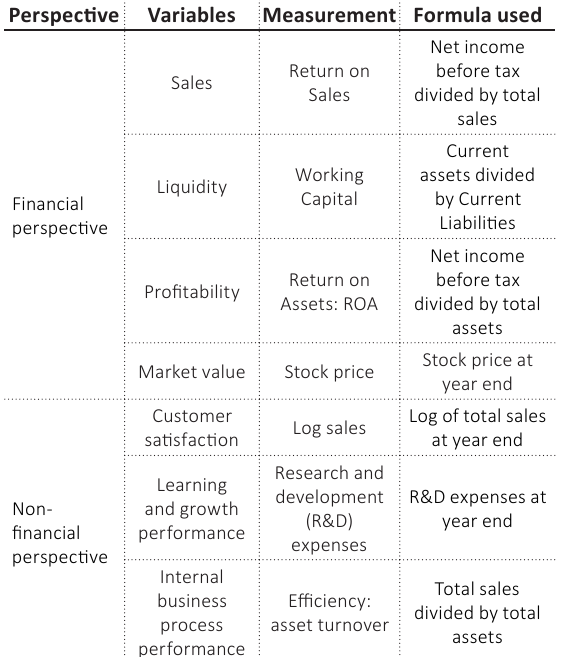
Table 1. Balanced scorecard perspectives and their